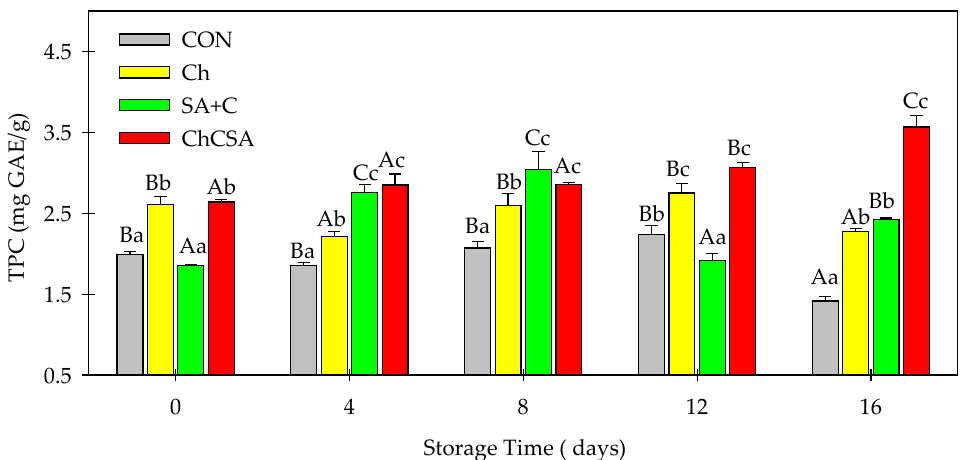
Figure 10. The effect of single-layer and gel coatings on the total phenolic content on fresh-cut purple sweet potatoes. Vertical bars represent means and standard deviation. Bars with different alphabets within the same storage day (lower case) or same treatment group at different storage days (upper case) are significantly different (Tukey’s HSD Test, p ≤ 0.05).